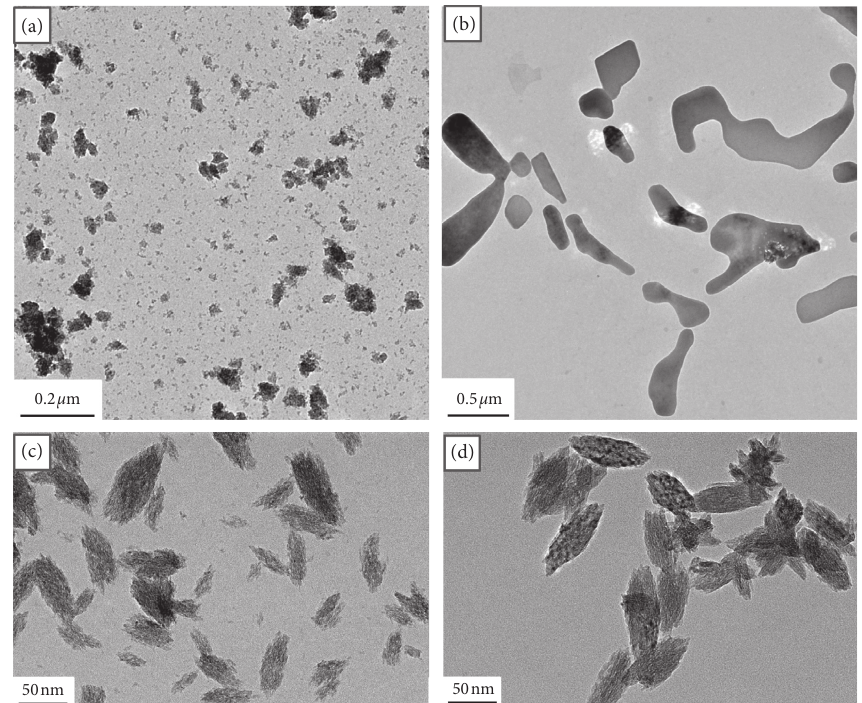
Figure 6: TEM images of YVO 4 nanocrystals produced through ultrasonic irradiation for 2h at (a) pH (d) pH �